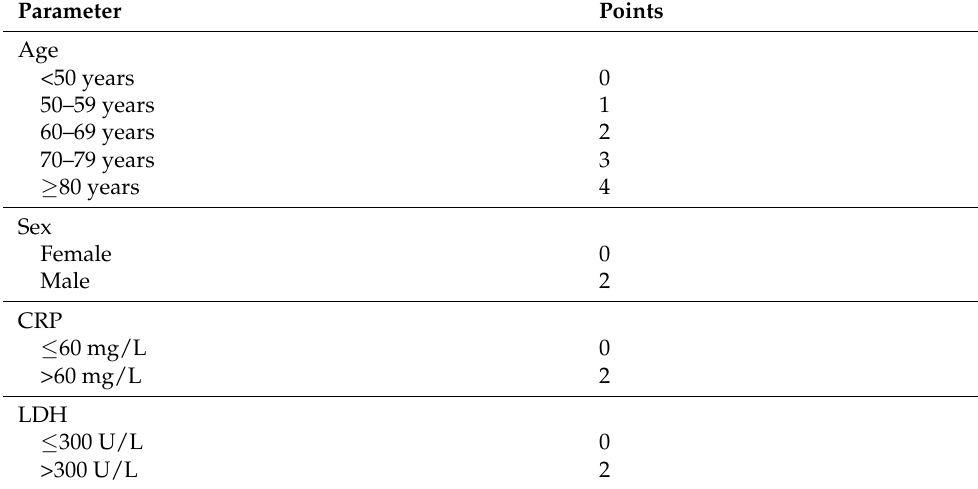
Table 5. The ASCL score, based on age, sex, CRP at hospital admission, and LDH at hospital admission. Parameter